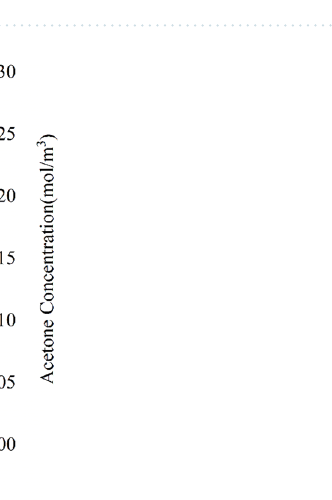
Figure 5. ( a ) Transient concentration distribution of acetone gas. ( b ) The acetone concentration distribution in the early time. ( c ) Partial enlargement of ( b ). ( d ) The acetone concentration distribution at the next moment of ( b ). ( e ) Partial enlargement of ( d ).